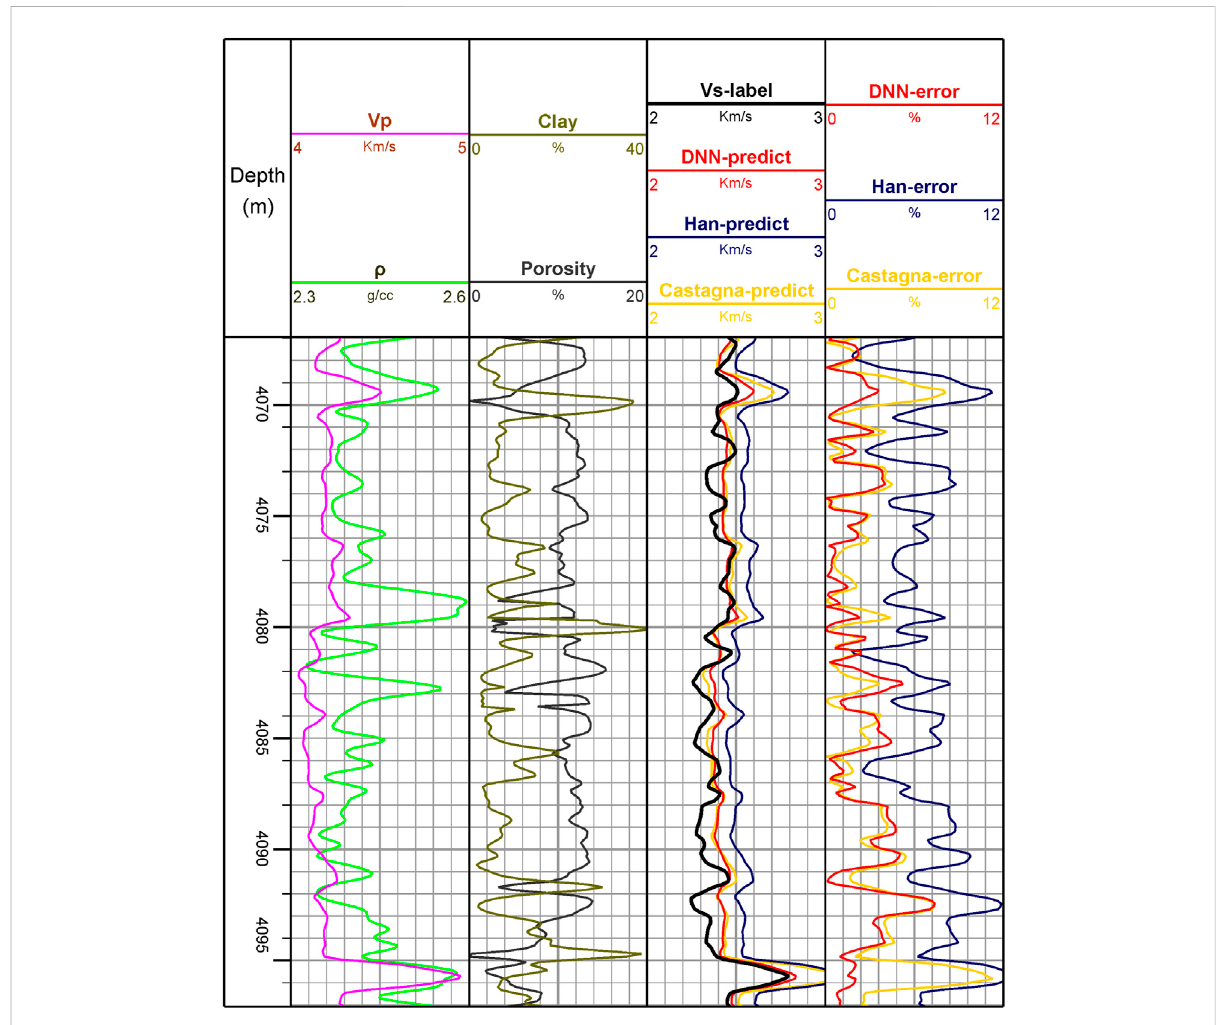
FIGURE 8 Data information of well 1 and S-wave velocity prediction results (Vs-label is the logging S-wave velocity, xx-predict indicates the result predicted using a certain method, and xx-error indicates the corresponding relative error).